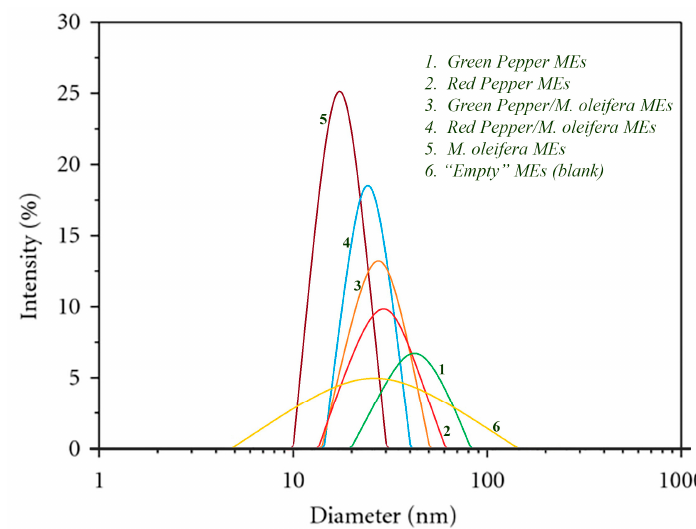
Figure 3. Particle size distribution of ΜΕ s.